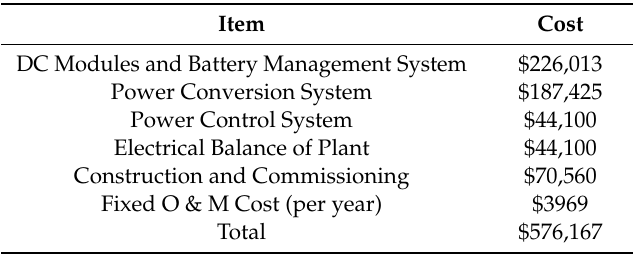
Table 3. Initial costs of energy storage systems.